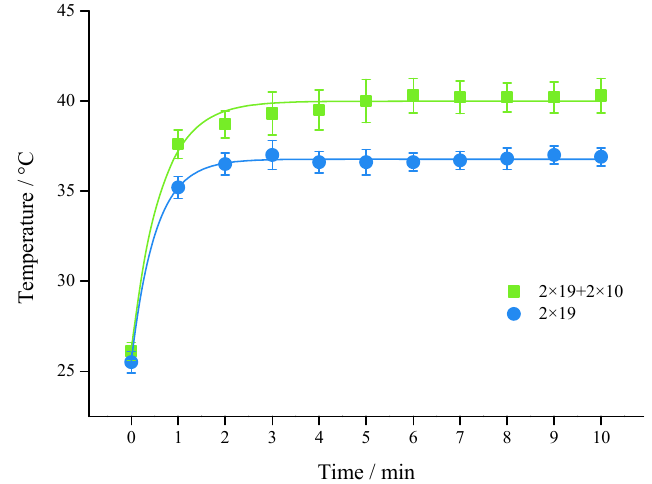
Figure 4. Temperature profile with different secondary coils (2 × 19 + 2 × 10 and 2 × 19) of apple juice at 800 V, 400 Hz, d 1 = 1 mm, L 1 = 10 cm.